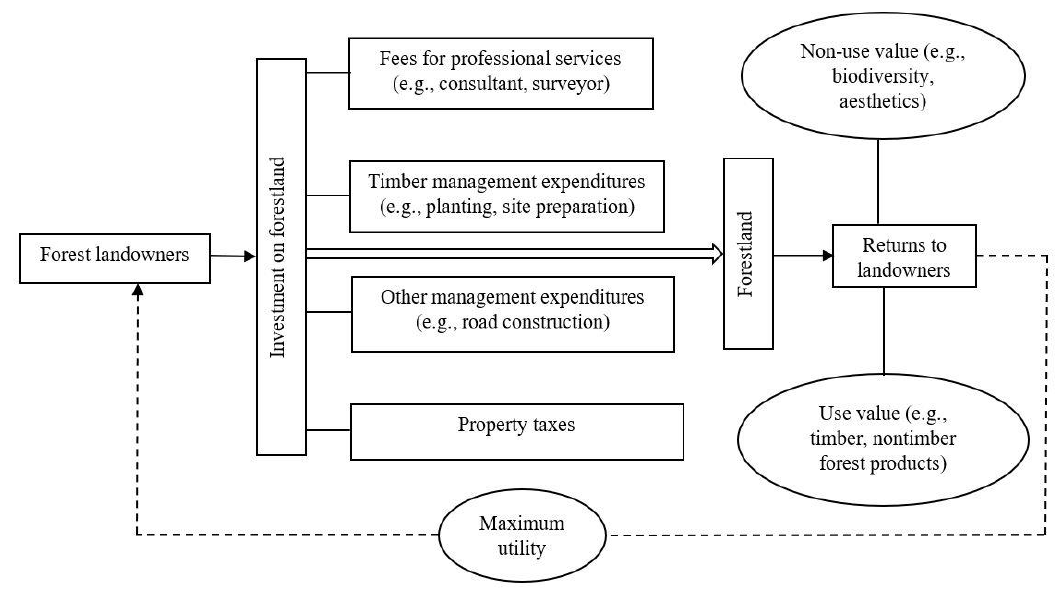
Figure 1. Conceptual model of landowners’ expenditure to maximize utility .